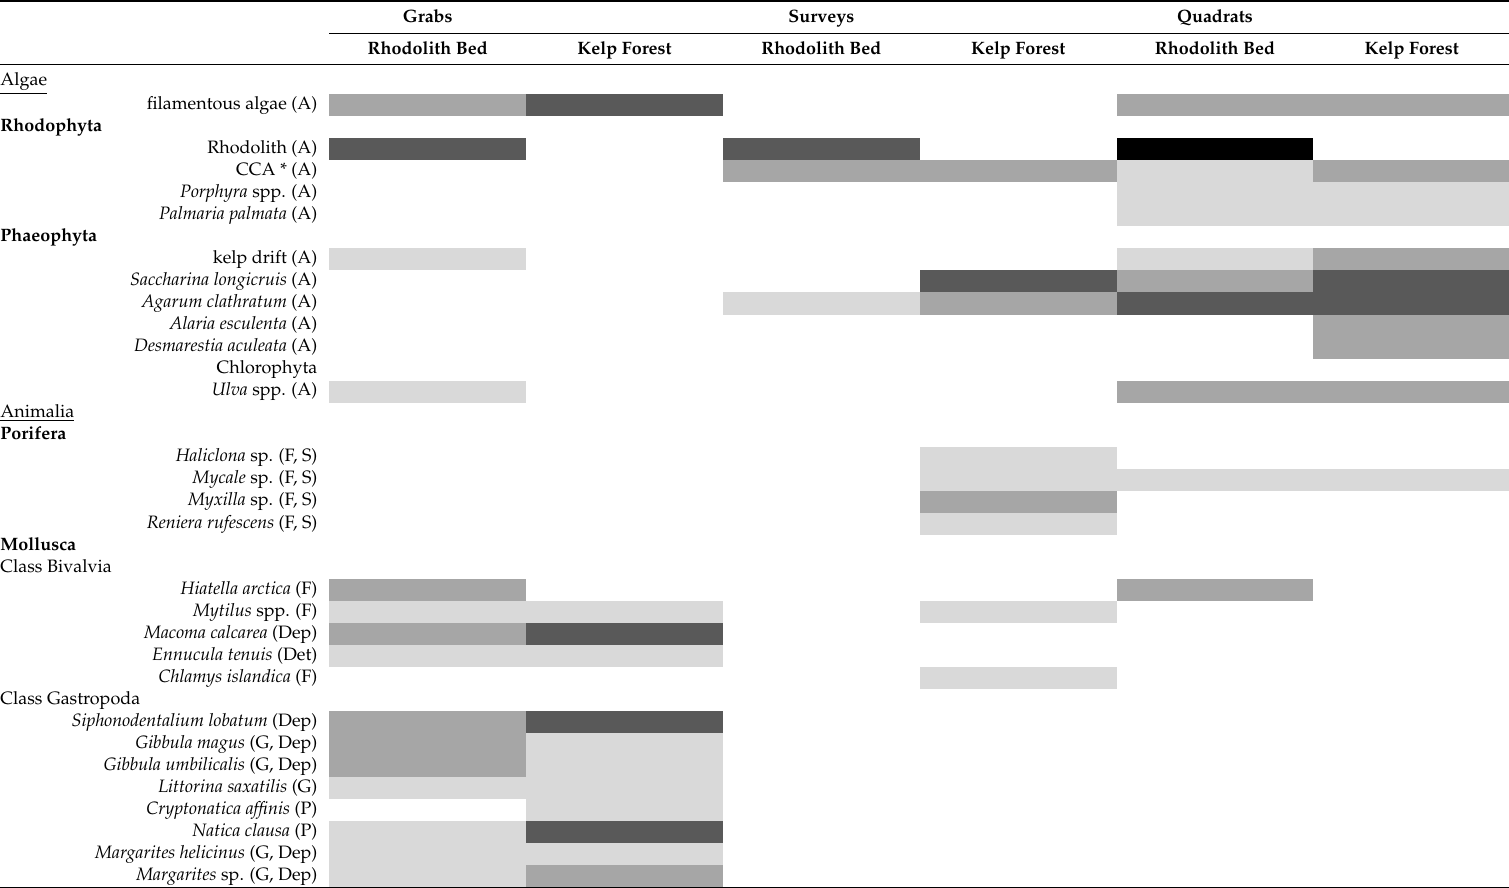
Table 2. List of species grouped by phylum from all kelp and rhodolith beds in the Nuuk region with a grey-scale indication of SACFOR abundance scale [55] in each habitat; white indicates no record, light-grey present, medium-grey is frequent, dark-grey is common, and black indicates abundant. Species identification was done to the lowest taxonomic unit possible in lab (preserved in ethanol) and with photographic records. Some species are grouped such as the filamentous algae and micrograzers because higher resolution was not possible. All taxonomic units include their feeding method: (A) autotroph, (Dep) deposit feeder, (Det) detritivore, (F) filter feeder, (G) grazer, (O) omnivore, (P) predator, (S) suspension feeder, and (U)